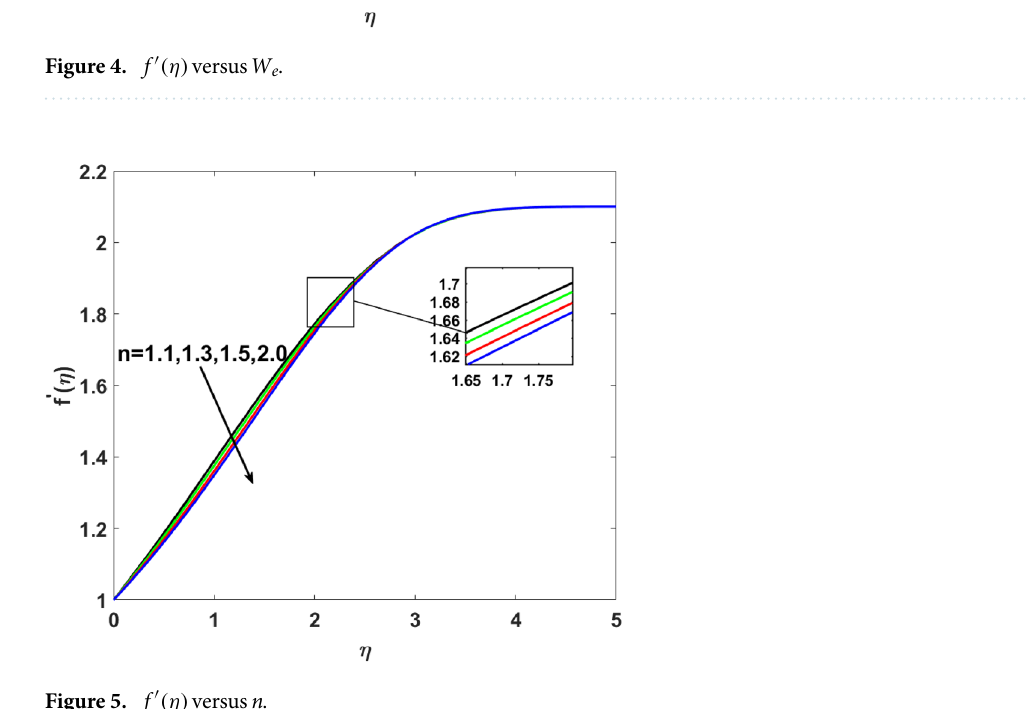
Figure 5. f ′ (η) versus n